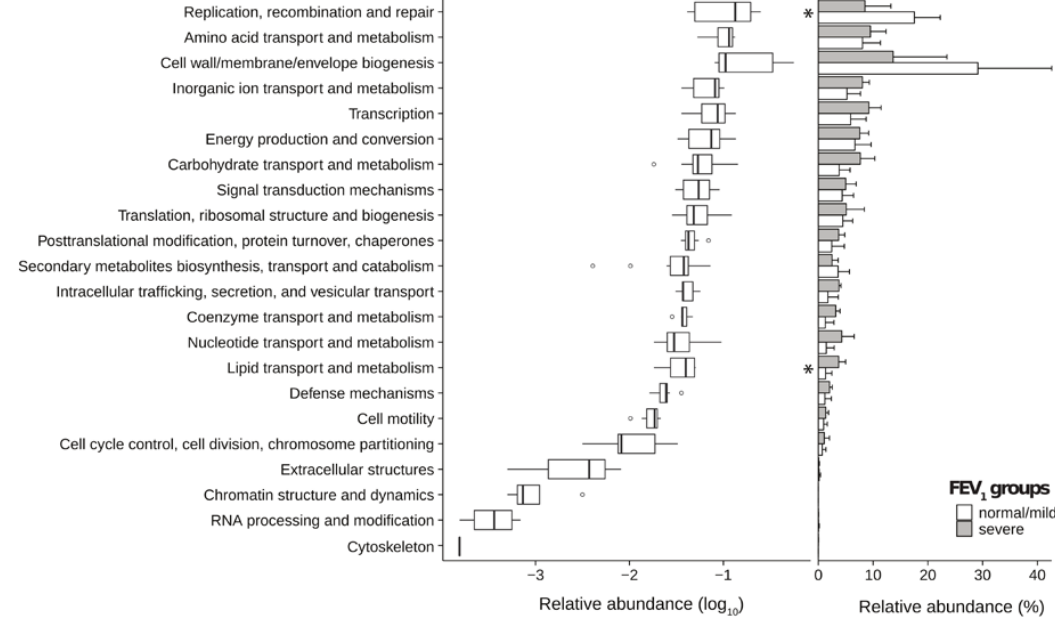
Figure 3. Distribution of functional categories obtained with an evolutionary genealogy of genes: non-supervised orthologous groups (eggnog) analysis. Box plots for each eggNOG category found for both groups of patients are reported in the left panel, whereas relative abundances for each group are reported in the right panel (bars represent the average value and error bars indicate the standard error for each measure). Significant differences between normal/mild and severe groups are flagged with an asterisk. Boxes denote the interquartile range (IQR) between the 25th and the 75th percentile (first and third quartiles), whereas the inner line represents the median. Whiskers represent the lowest and highest values within 1.5 times IQR from the first and third quartiles. Outliers are reported using white circles.